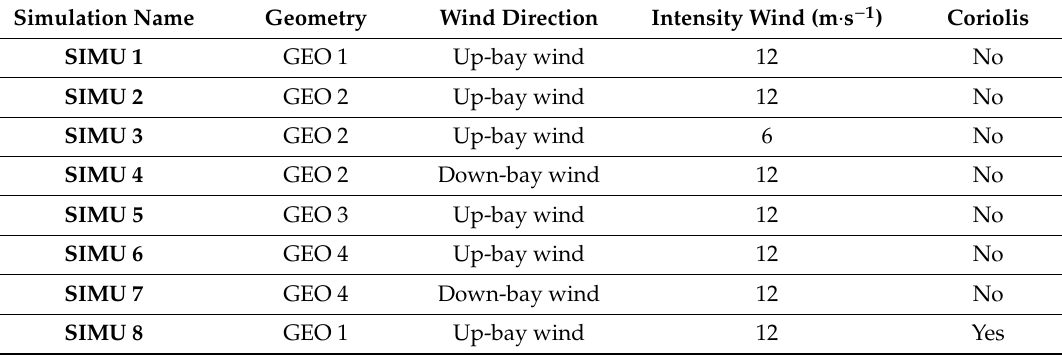
Table 2. Summary of the di ff erent simulations used in Regional Ocean Model System